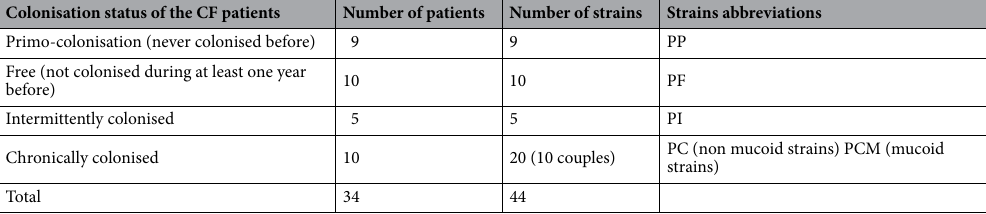
Table 1. Distribution of Pa strains according to the colonisation status of CF